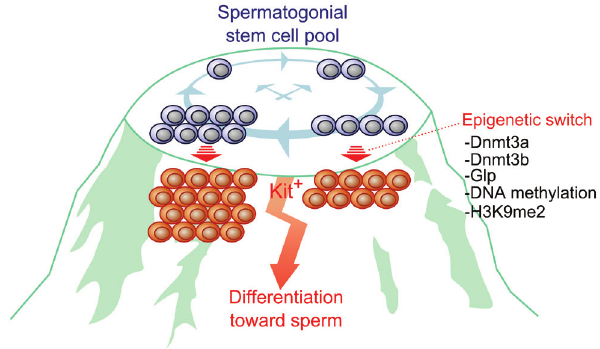
Figure 2 The epigenetic switch model for spermatogonial stem cell